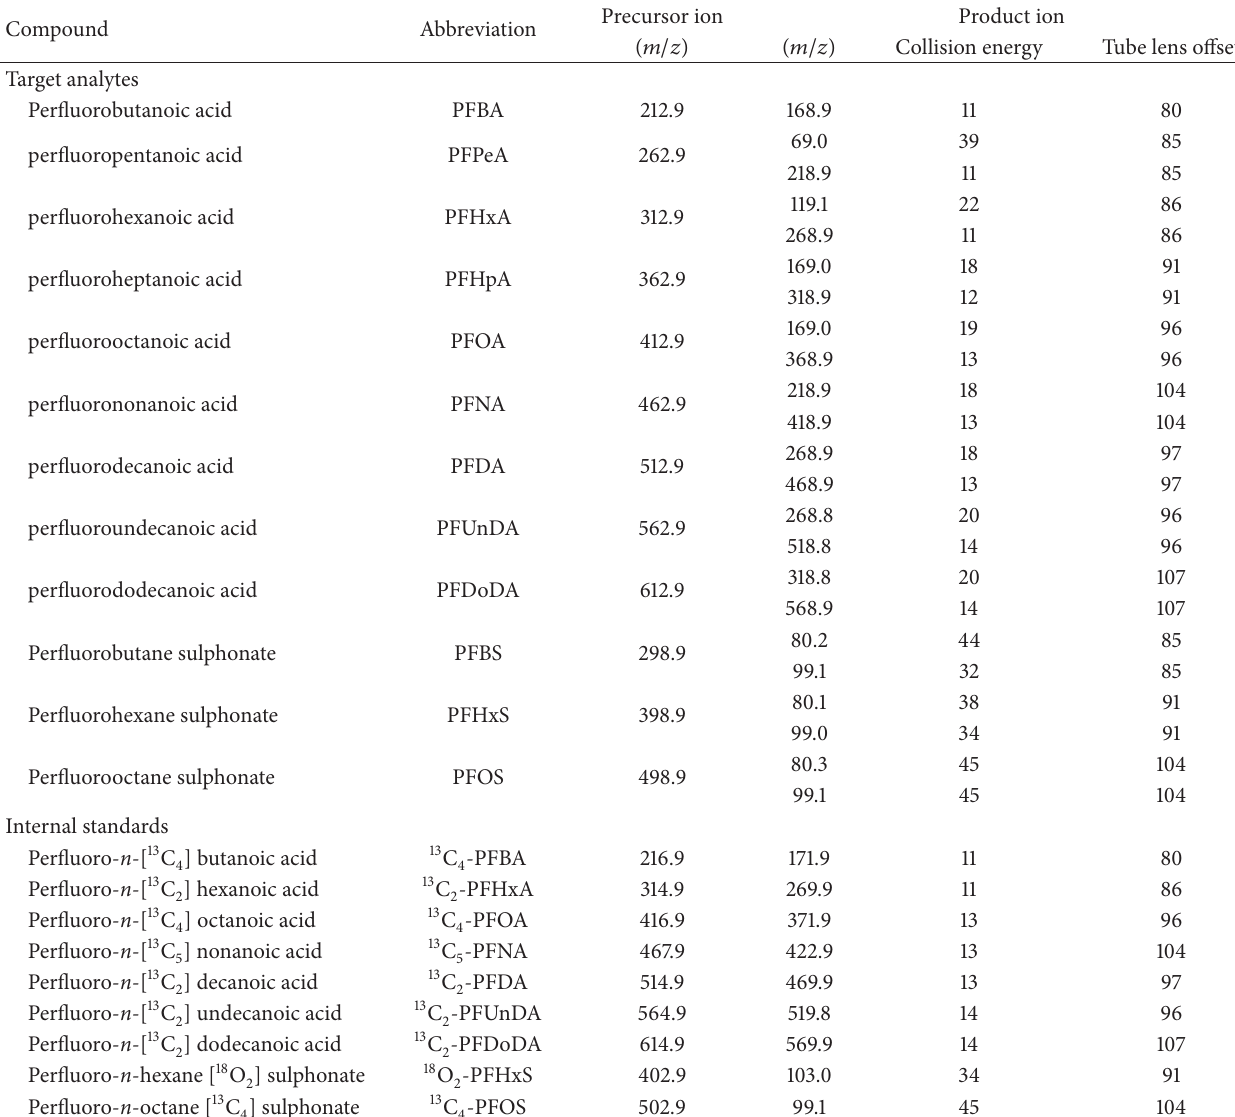
Table 2: LC/MS/MS parameters for all target analytes and internal